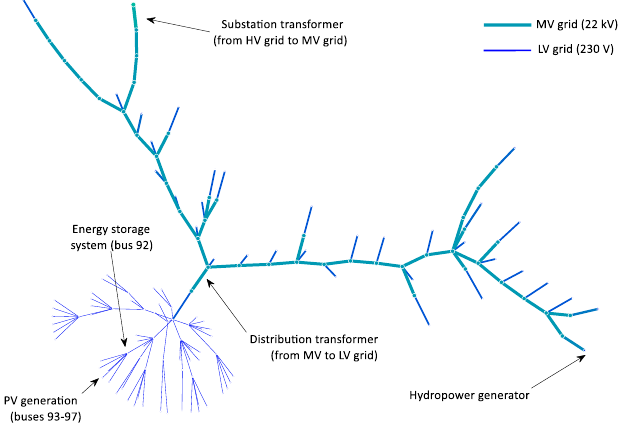
Figure A1. Schematic of distribution grid considered in the case study, prepared using the visualization techniques of [63].